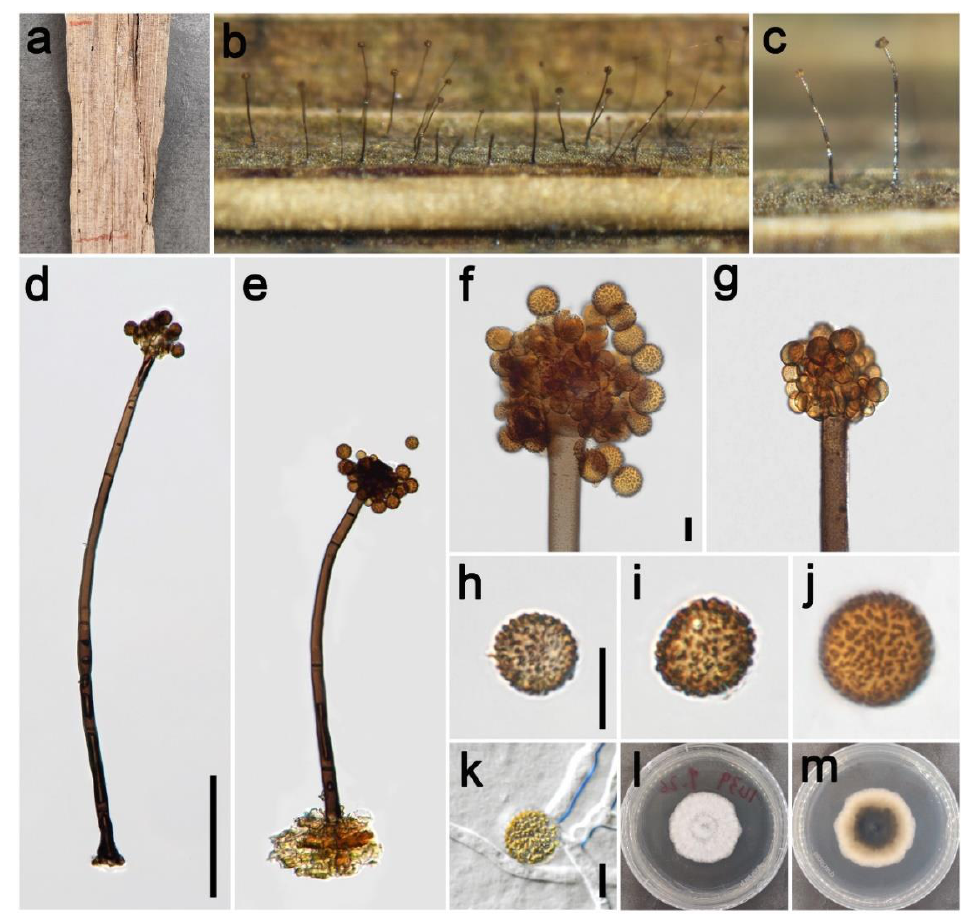
Figure 10. Periconia pseudobyssoides (HUEST 22.0136). ( a – c ) Colonies on the natural substrate; ( d , e ) conidiophores with spherical conidial heads; ( f , g ) conidial heads bearing conidiogenous cells and conidia; ( h – j ) conidia; ( k ) germinating conidium; ( l , m ) colony on PDA from above and below. Scale bars: ( d ) = 100 µm, ( f , h , k ) = 10 µm. Scale bar of ( d ) applies to ( e ). Scale bar of ( f ) applies to ( g ). Scale bar of ( h ) applies to ( i , j ).